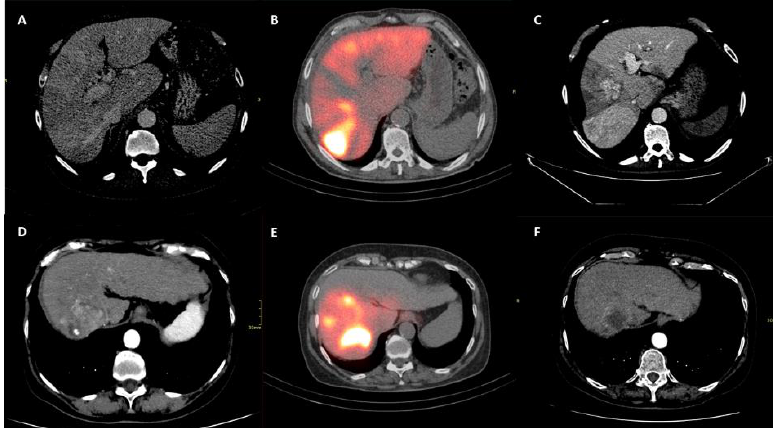
Figure 4. Upper row ( A – C ) shows patient who underwent to progression disease. Lower row ( D – F ) shows patient who underwent to complete response. ( A , D ) show liver disease on multiphasic CT before intra-arterial radioembolization. ( B , E ) show correctly targeted radioembolization on post-procedural SPECT – CT. ( C , F ) show tumor response on CT follow up.